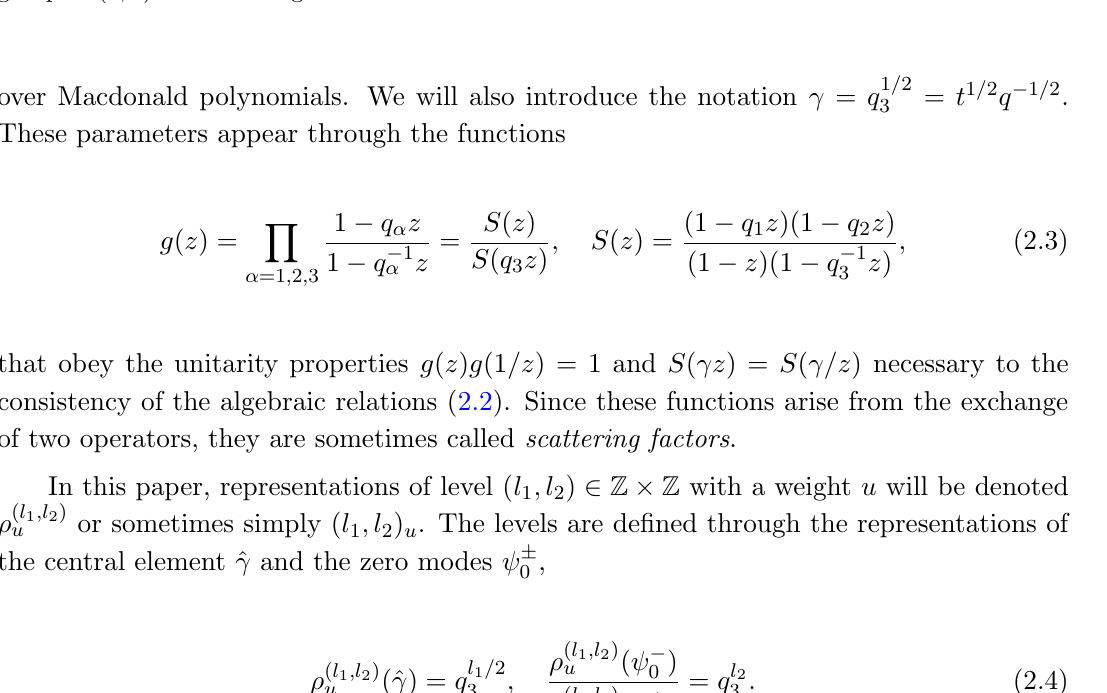
Figure 1 . DIM generators represented on a Z (cid:10) 2 lattice where the S -transformation of the modular group SL(2, Z ) acts a 90 degrees